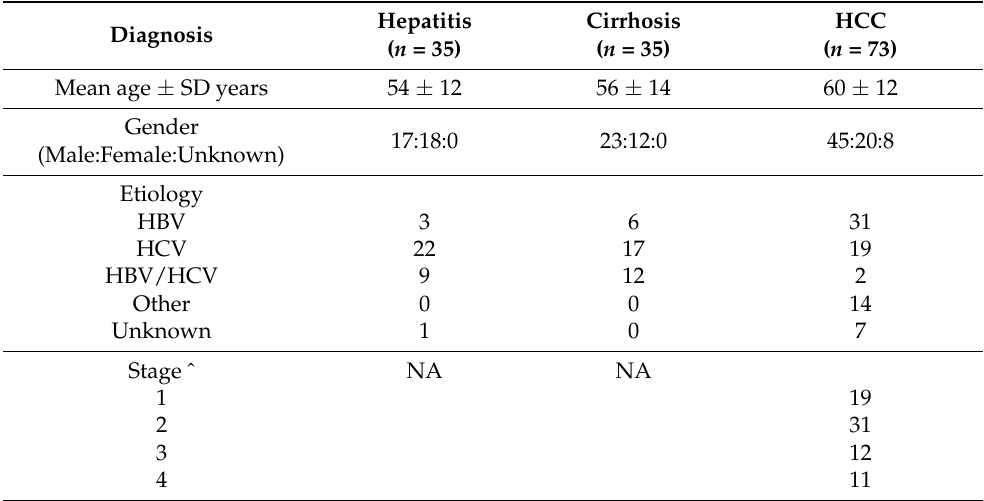
Table 1. Clinicopathological characteristics of the cohort 1 tissue DNA * analyzed in this